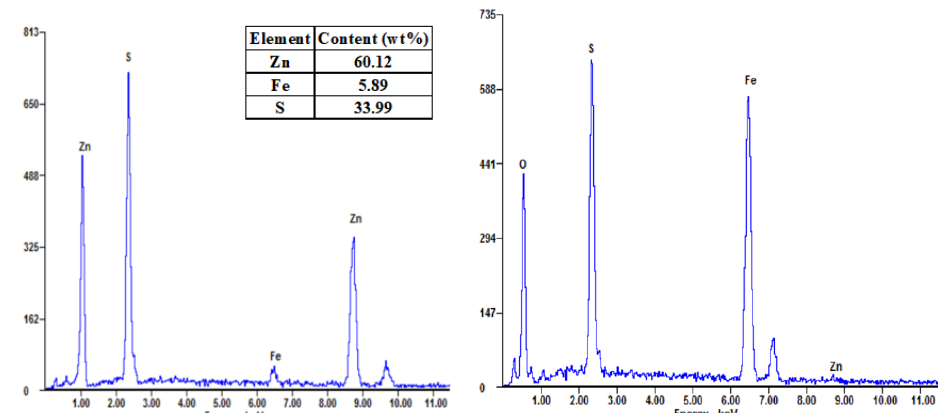
Figure 3. EDS results of micro area A (sphalerite) and B (right) in Figure 2.